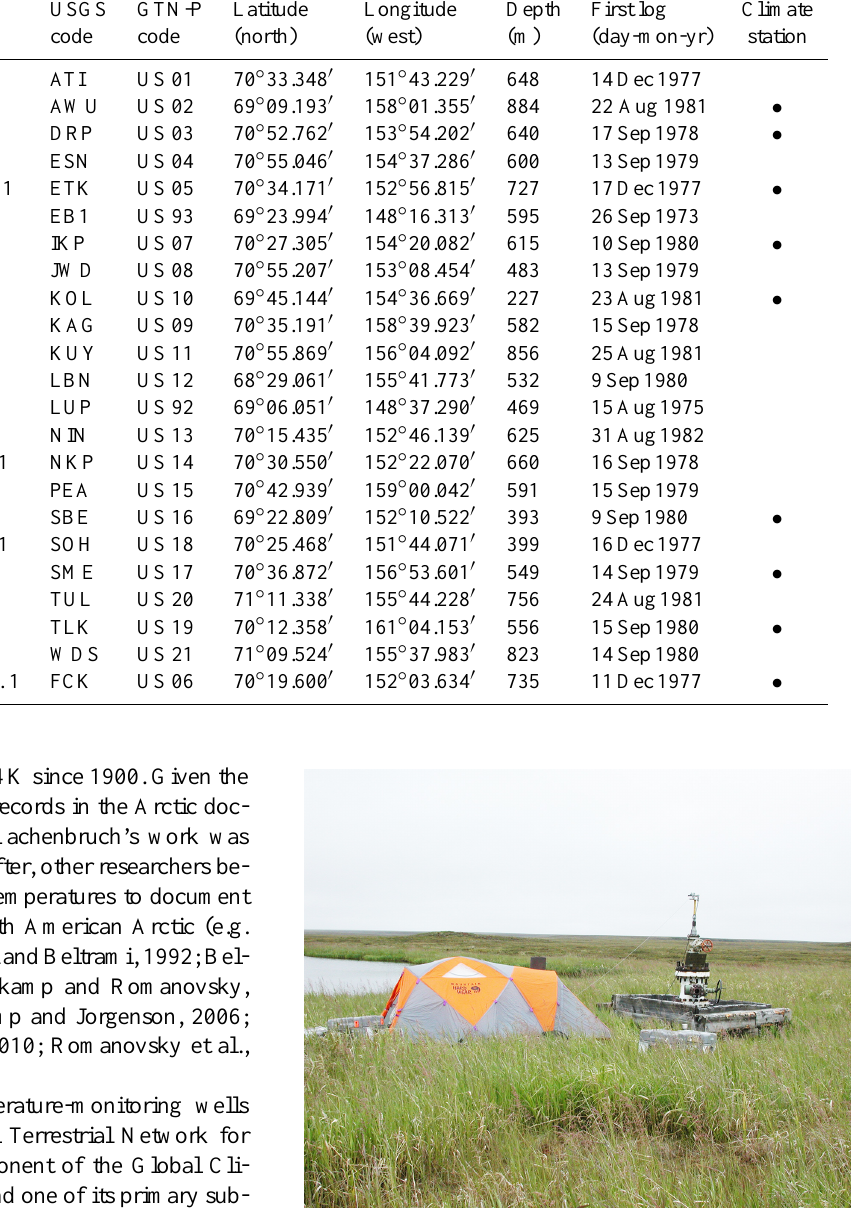
Figure 3. Measuring temperatures in the Koluktak (KOL) Test Well No. 1, National Petroleum Reserve–Alaska. This well is typical of the other wells in the DOI/GTN-P Deep Borehole